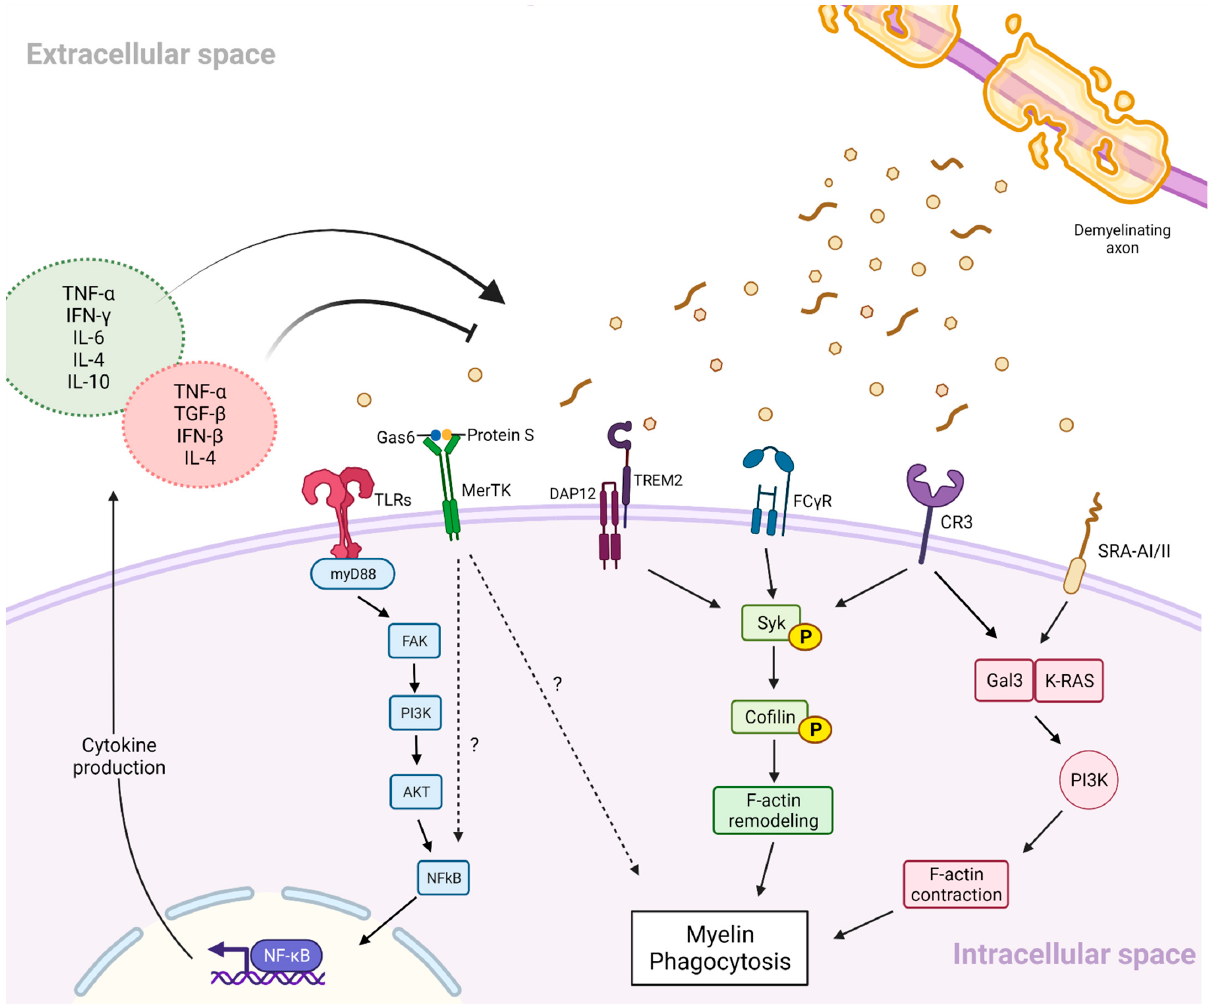
Figure 1. Schematic overview of the main signalling pathways involved in myelin phagocytosis by microglia . In the figure, the molecular signalling pathways associated with microglial-mediated myelin debris phagocytosis are shown. Briefly, myelin debris is recognised by TLRs, MerTK, TREM2, FC γ R, CR3, or SRA-AI/II receptors, which in turn stimulates the release of pro- and anti-inflammatory cytokines. Cytokines released in the extracellular space trigger the activation of several signalling pathways involved in the remodelling and contraction of the cytoskeleton, thereby facilitating the engulfment of myelin debris.